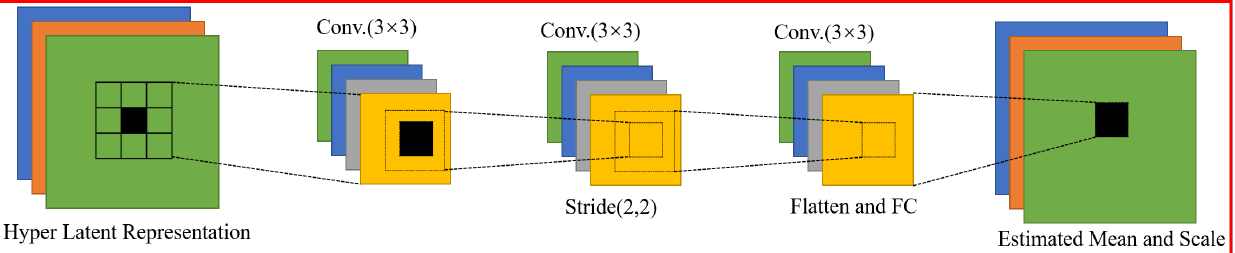
Figure 3. Estimation